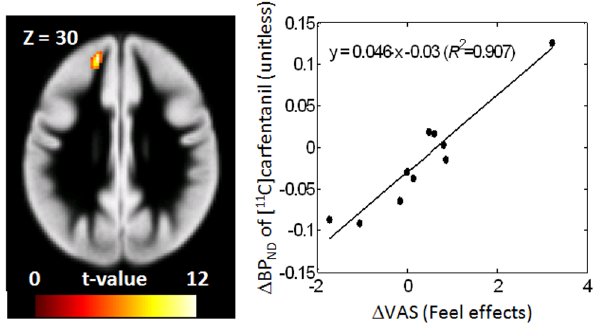
Fig. 2. Positive correlation clusters of D [ 11 C]carfentanil binding potential (BP ND ) (placebo - active) versus D VAS of feel the effect category in smokers, displayed on trans-axial images of a gray-matter probability maps. Scatter plots of cluster D [ 11 C]carfentanil BP ND values to D VAS are shown together with regression lines. VAS stands for the visual analog scale of smoking effects, and R 2 stands for the coefficient of determination of linear